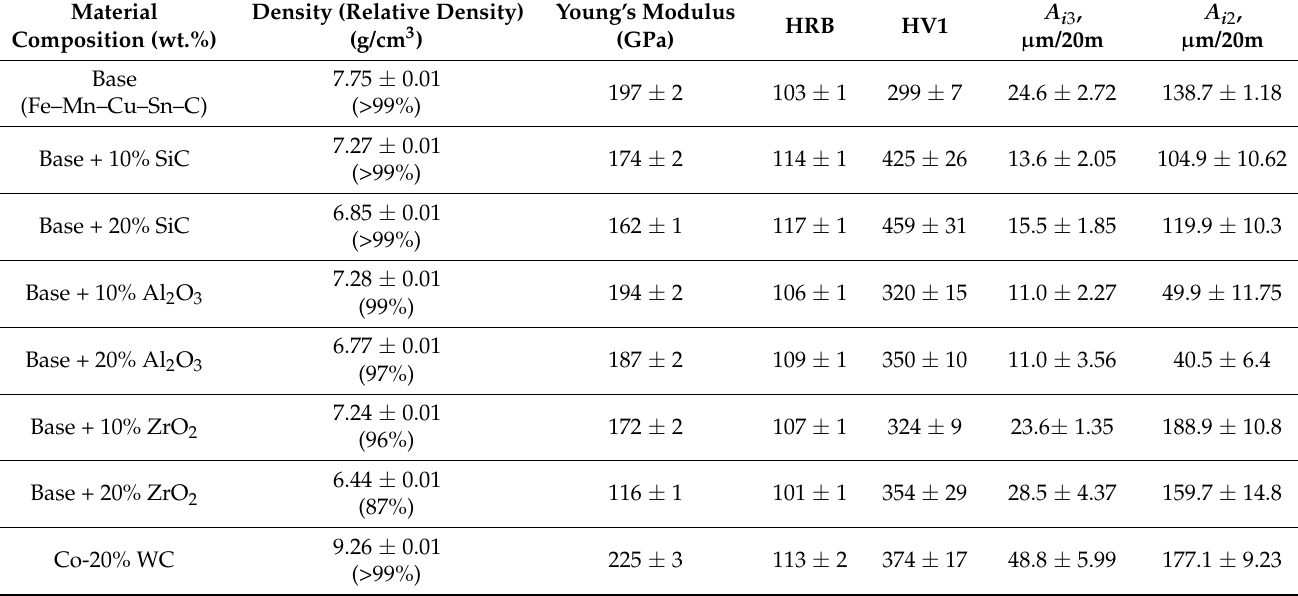
Table 2. Basic physical and mechanical properties of composites sintered by SPS at 900 ◦